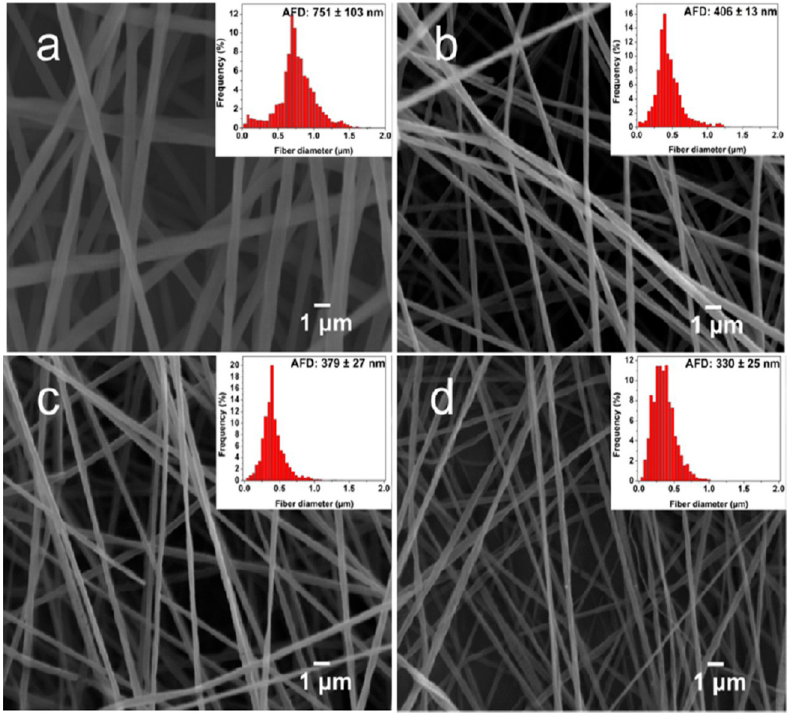
Figure 11. SEM images of electrospun ( a ) PLA, ( b ) PLA / 1 wt% GO, ( c ) PLA / 3 wt% Ag, and ( d ) PLA /